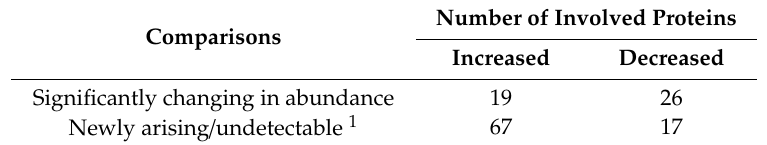
Table 3. Numbers of DEPs in the treatment group compared with the control group.